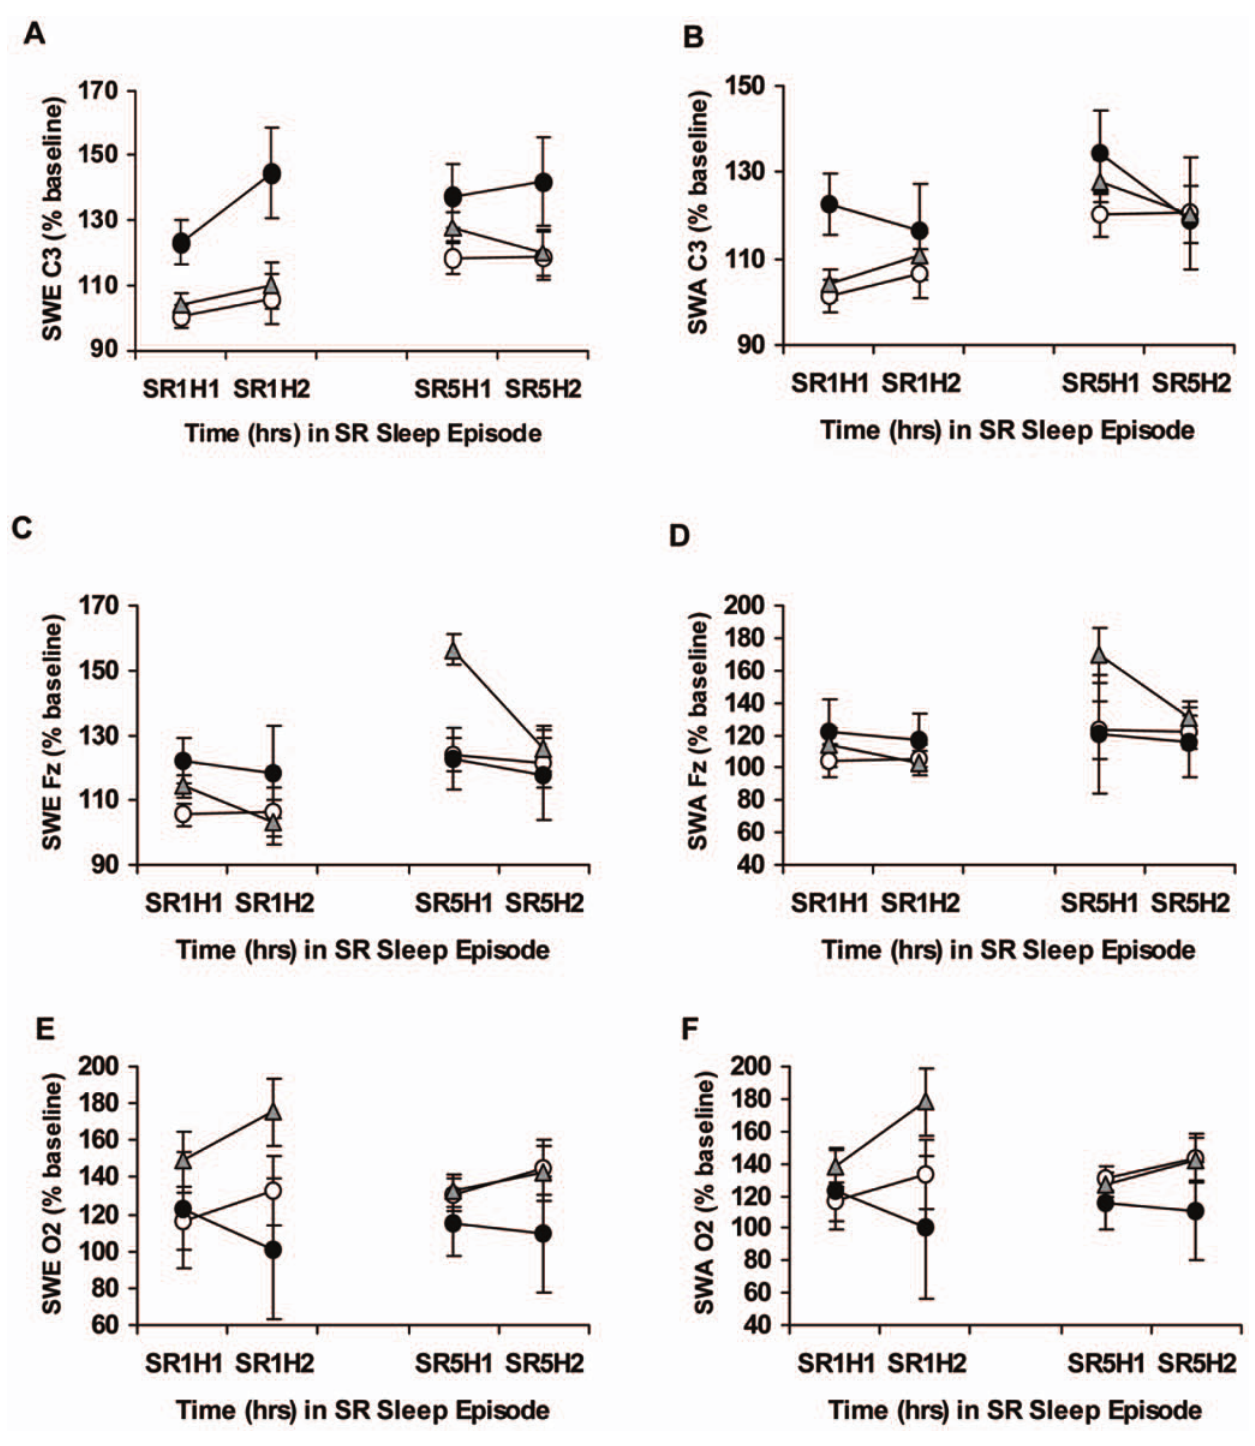
Figure 5. Slow-wave energy and slow-wave activity during chronic partial sleep deprivation for the PER3 genotypes. Mean ( 6 SEM) hourly slow-wave energy (SWE) and slow-wave activity (SWA) as a percentage of baseline at the same corresponding hour derived from the C3 (A, B), Fz (C, D) or O2 (E, F) channels at partial sleep deprivation/restriction night 1 (SR1) and partial sleep deprivation/restriction night 5 (SR5) for hour 1 (H1) and hour 2 (H2) in PER3 4/4 (open circles) , PER3 4/5 (gray triangles) and PER3 5/5 (closed circles) subjects. SWE derived from C3 (but not from Fz or O2) was significantly higher during chronic PSD in PER3 5/5 compared with PER3 4/4 and PER3 4/5 subjects. doi:10.1371/journal.pone.0005874.g005 terms of time of day and executive tests affected—indicate that In summary, the PER3 4/4 , PER3 4/5 and PER3 5/5 genotypes other genetic polymorphisms may influence executive function demonstrated comparable cumulative increases in sleepiness and and cognitive performance deficits resulting from TSD. cumulative decreases in cognitive performance and physiological